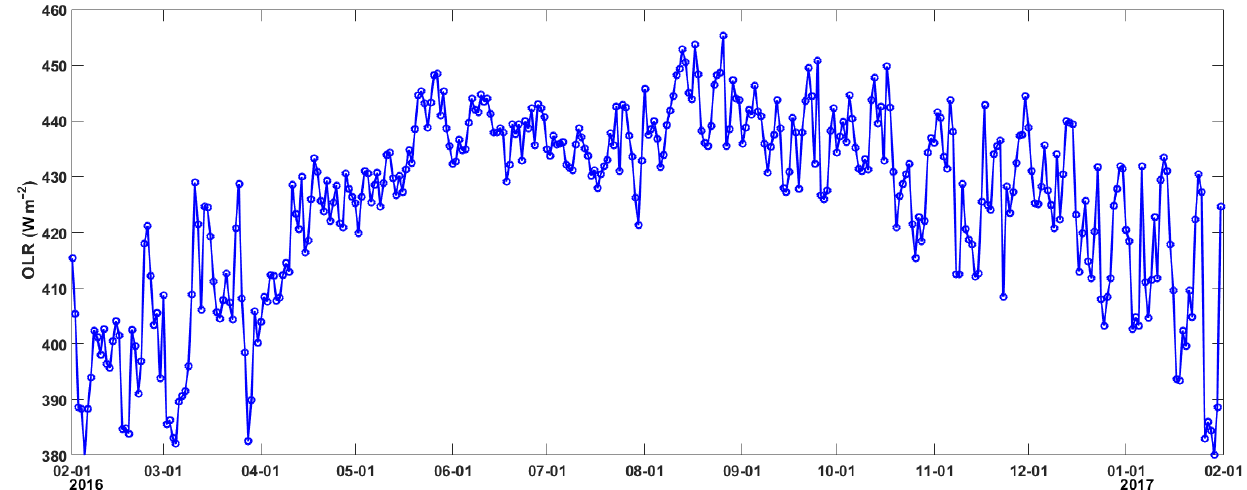
Figure 8. Daily mean time-series plots of the YXASFT observed downward long radiation (DLR) over the study period (1 February 2016– 31 January 2017).